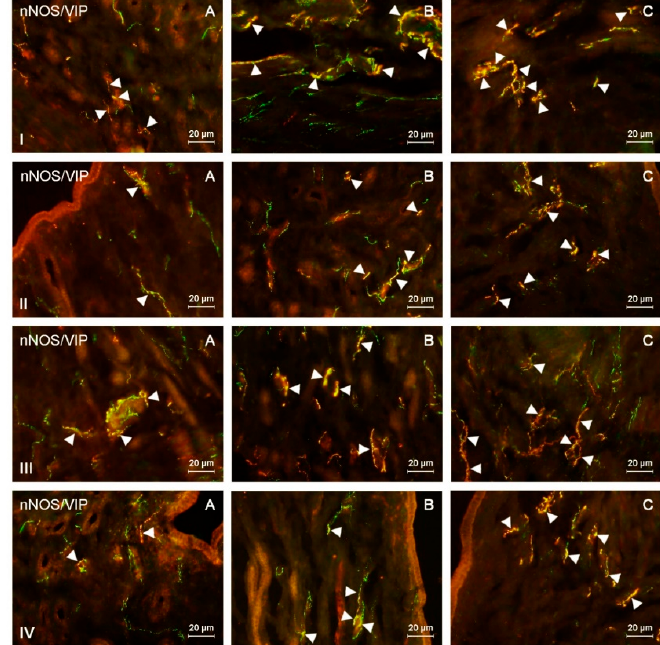
Figure 2. nNOS-positive nerves (nNOS+ green) immunoreactive to vasoactive intestinal polypeptide (VIP) (red) in the: (I) muscular layer of the corpus, (II) mucosal layer of the corpus, (III) muscular layer of the horns, (IV) mucosal layer of the horns of the uterine body of control animals ( A ) and pigs treated with low ( B ) and high ( C ) dose of bisphenol A. Nerves simultaneously immunoreactive to nNOS and VIP (yellow) are indicated with arrowheads.